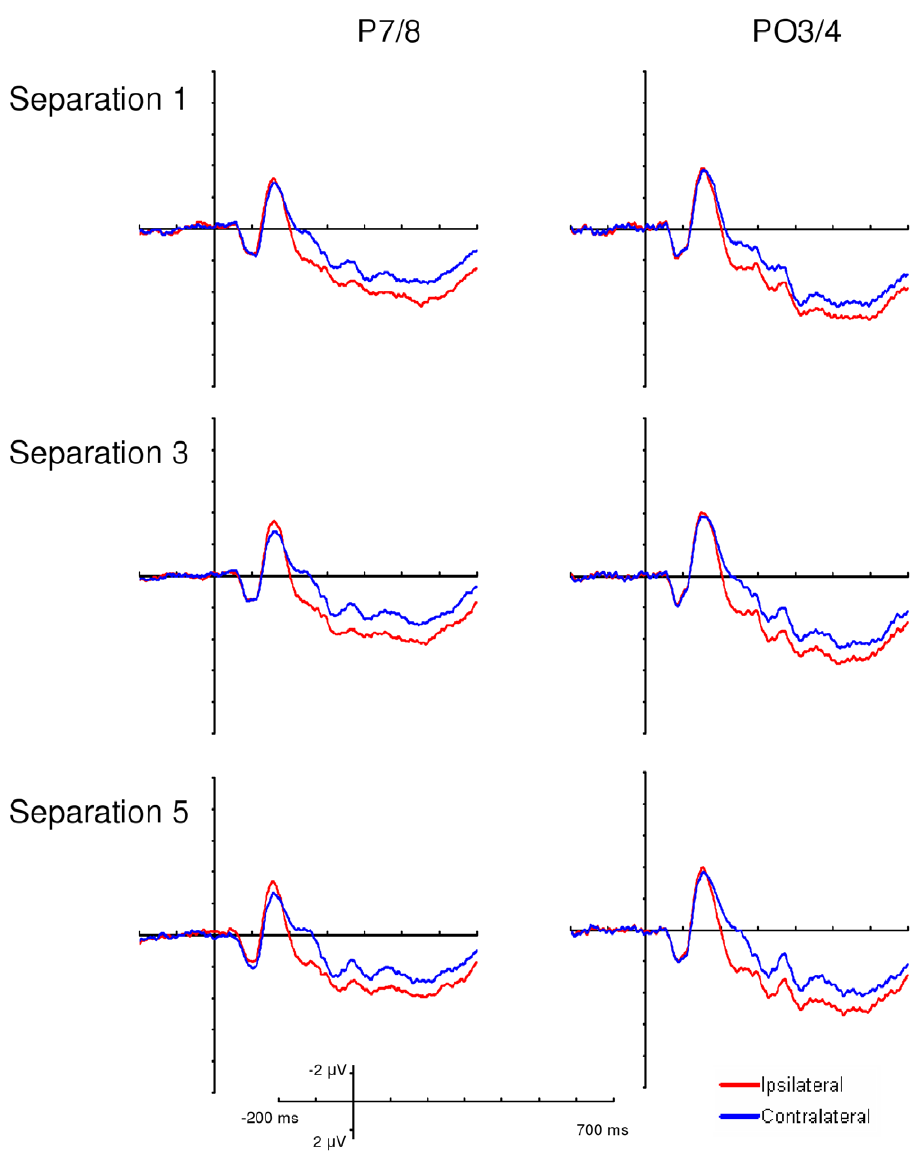
Figure 3. Ipsilateral and contralateral waveforms from Experiment 1. Displayed are the ipsilateral and contralateral grand average waveforms for electrodes P7/8 and PO3/4 at each level of target-target separation from Experiment 1. Note that N2pc amplitude increases with increasing target-decoy separation and Ptc amplitude does not vary with target-target separation.